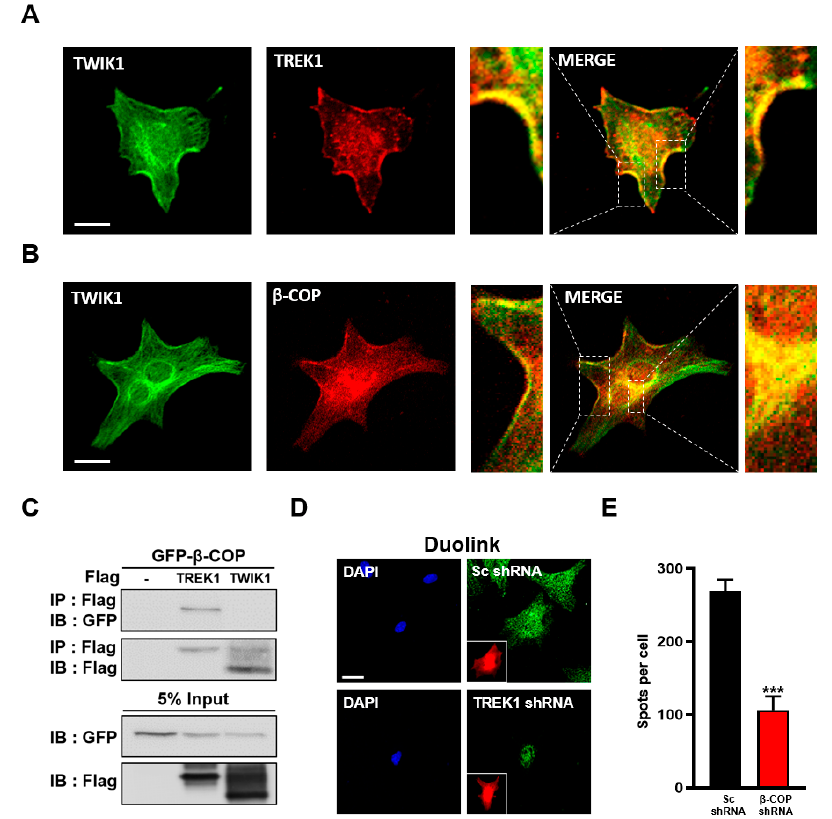
Figure 5. β -COP interacts with TWIK1 in a TREK1-dependent manner. ( A ) Representative immunocytochemical images of astrocytes stained with the anti-TWIK1 and anti-TREK1 antibodies. Enlargement of the merged images indicates colocalization of TWIK1 and TREK1 in the astrocyte membrane. Scale bar, 20 µm. ( B) Representative immunocytochemical images of astrocytes stained with anti-TWIK1 and anti- β -COP antibodies. Enlargement of the merged image indicates colocalization of TWIK1 and TREK1 in the plasma membrane and inside the cell. Scale bar, 20 µm. ( C ) Co-IP in HET293T cell. After transfection of GFP- β -COP with Flag-TREK1 or Flag-TWIK1, immunoprecipitation with Flag antibody was performed and blotted with GFP antibody. ( D ) Duolink PLA assay. Intense PLA signals (green) were detected in Sc shRNA-transfected astrocytes; however, astrocytes transfected with TREK1-shRNA rarely showed PLA signals. The red fluorescent signals of mCherry protein indicated transfection of Sc shRNA or TREK1-shRNA expression vectors, which also expressed mCherry proteins as shown in Figure 4A. DAPI signals indicated nucleus of the astrocytes. Scale bar, 20 µm. ( E ) The PLA signals were counted using ImageJ software, and the average number of spots per cell is presented in the graph. The numbers on each bar indicate the n for each condition. All values are expressed as the mean ± SEM (*** p < 0.001). SEM, standard error of the mean. p -values were obtained with Student’s t -test.